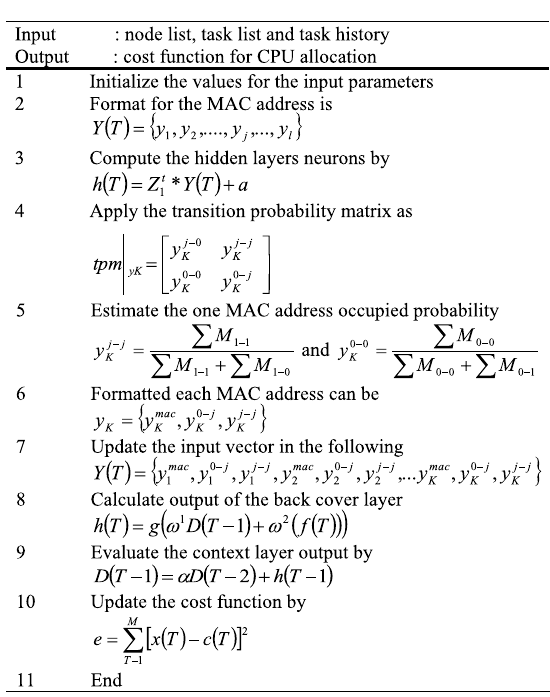
Algorithm 3 Pre-virtual CPU allocation using FARNN